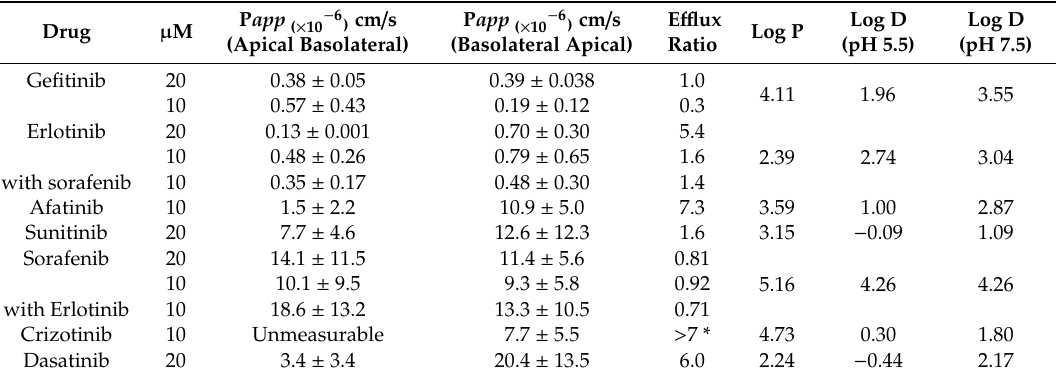
Table 2. Physical and transport properties of seven approved tyrosine kinase